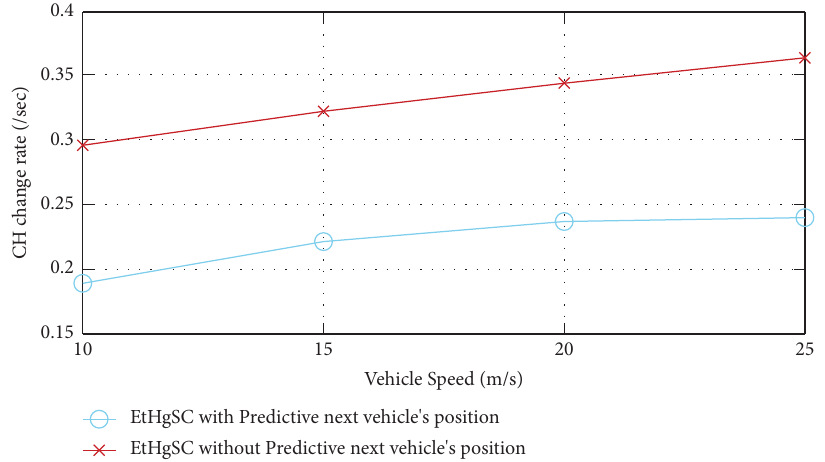
Figure 8: CH change rate for EtHgSC with and without predicted next vehicle’s